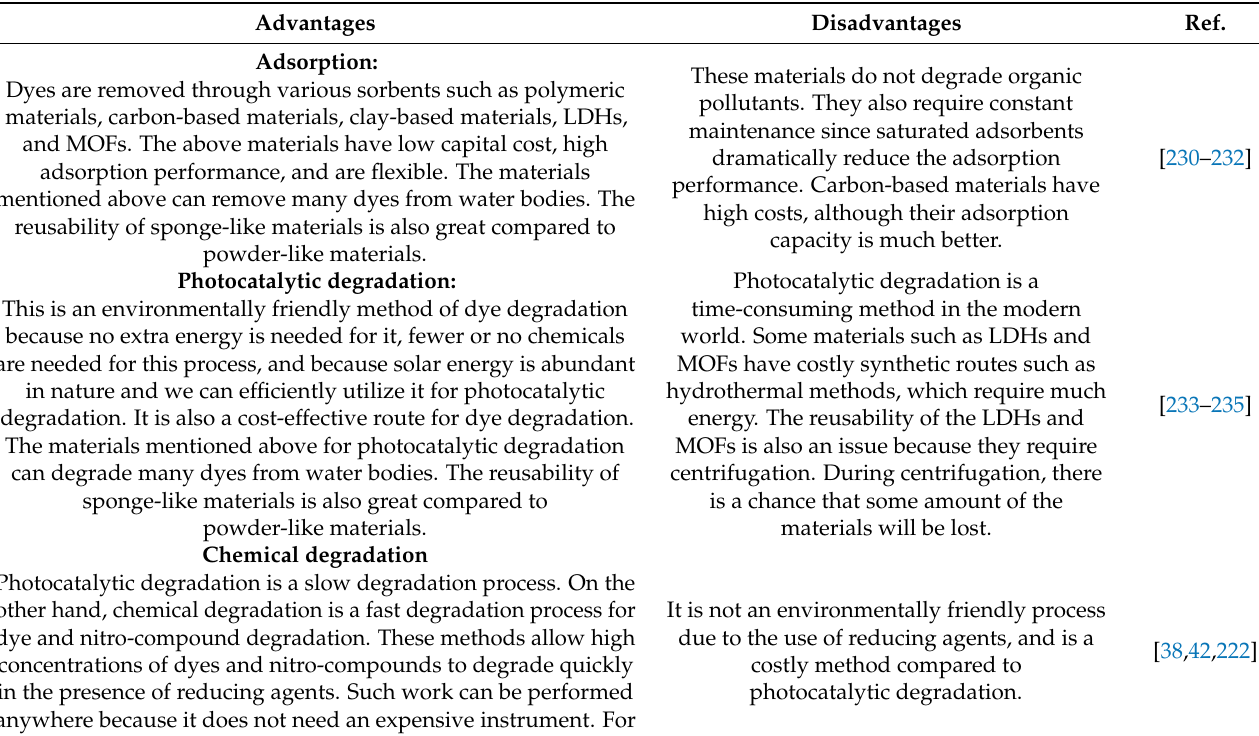
Table 6. Advantages and Disadvantages of Adsorption, Photo-, and Chemical